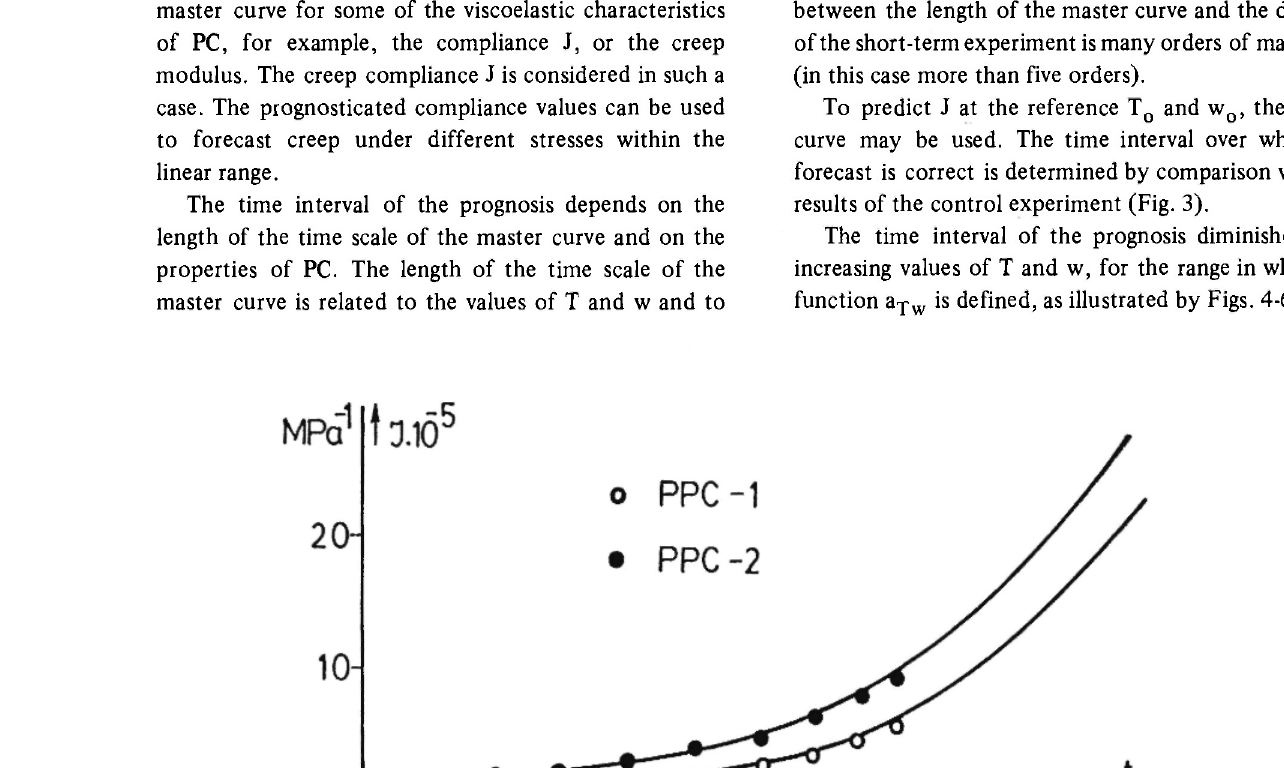
Fig. 3: Compliance curves at Τ = 20° C and w = 0.01%, forecast by TTMA (master curves) for two compositions of PPC, compared with experimental values obtained from control tests.